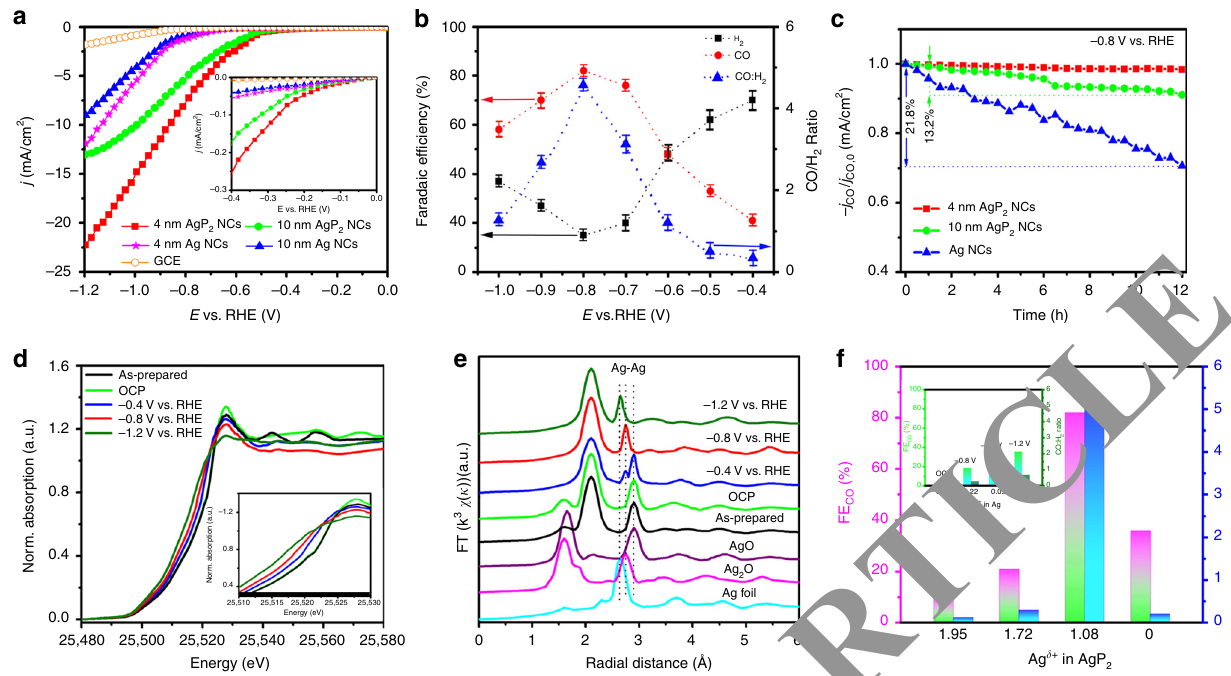
Fig. 2 Electrochemical measurements in CO 2 -saturated 0.5 M KHCO 3 solution. a Linear sweep voltammetric curves; b Faradaic ef fi ciency of CO and H 2 and CO/H 2 ratio; c stability of partial CO current density ( j CO ) measured at − 0.8 V vs. RHE for 12 h. d In situ silver K-edge XANES and e EXAFS spectra of 4 nm AgP 2 NCs after 30 min at the speci fi ed potential. Pristine AgP 2 NCs, AgO, Ag 2 O, and Ag foil are included as references. f Faradaic ef fi ciency of the CO and CO:H 2 ratio as a function of Ag δ + in AgP 2 and Ag. Fig. 12). For comparison, a much lower FE CO,max and narrower (EASA) and interfacial charge transfer rate (Supplementary Figs. 8a and 9). The onset potential ( E onset, CO ) for initial CO CO:H 2 range is observed for Ag NCs (Supplementary Tables 6 generation (de fi ned as the potential required for j CO = − 0.01 mA and 7). To check that the NC surface is exposed, the effects of removing surface capping ligands on the electrochemical surface cm − 2 ) on 4 nm AgP 2 NCs is − 0.22 V vs. RHE, which is only area and FE CO are shown in Supplementary Fig. 13a – c. The Tafel 110 mV lower than the thermodynamic potential of CO 2 -to-CO reaction. In comparison, the E onset, CO for Ag NCs is − 0.59 V vs. RHE ( η = 480 mV). The 4 nm AgP 2 NCs exhibit an overpotential 10 nm Ag NCs is 105, 117, 168, and 184 mV/dec, respectively (Supplementary Fig. 14). The smallest Tafel slope for 4 nm AgP 2 for the same partial density of CO ( j CO ) that is consistently on the order of 0.3 V lower than 10 nm Ag NCs (Supplementary Fig. 10). NCs indicates that phosphorus plays a critical role in stabilizing The source of the anodic shift of onset potential and decreased the CO 2 - intermediate and accelerating the fi rst electron transfer overpotential for CO 2 -to-CO will be discussed below in detail. rate-determining step 6 . Additionally, the durability of 4 nm AgP 2 The performance of 10 nm AgP 2 NCs is also provided as a same- NCs, 10 nm AgP 2 NCs, and 10 nm Ag NCs was tested at a high size comparison to 10 nm Ag NCs, and also exhibit uniformly constant potential of − 0.8 V vs. RHE (Fig. 2c). A stable j CO with superior performance compared to Ag NCs. Notably, the 4 nm negligible decay within 12 h is observed on 4 nm AgP 2 NCs, AgP 2 NCs exhibit a remarkable geometric j CO of − 0.27 and − 8.7 compared to 13.2% and 21.8% activity decay for 10 nm AgP 2 NCs mA cm − 2 at − 0.5 and − 1.0 V vs. RHE, respectively, which is the and Ag NCs, respectively. ICP-MS, TEM, and XPS con fi rm that the 4 nm AgP 2 NCs remain almost the same after 12 h CO 2 one of the highest values reported for Ag-based electrocatalysts for CO 2 reduction (Supplementary Table 4). A maximum FE CO reduction (Supplementary Figs. 15 – 17). of 82% and minimum FE H2 of 15% is simultaneously achieved at − 0.8 V vs. RHE (Fig. 2b), indicating CO 2 -to-CO reduction is more favorable than the competitive HER on 4 nm AgP 2 NCs. The CO:H 2 ratio in the syngas product varies from 1:3 to 5:1 in the potential range of − 0.4 to − 1.0 V vs. RHE. This is the widest range of syngas proportions for all Ag-based electrocatalysts (Supplementary Table 4), and even superior or comparable to ciency, such as Au – Cu (1:2 to 4:1) 41 , Pd/C (1:4 to 1:1) 42 , Co 3 O 4 - CDots-C 3 N 4 (1:4 to 14:1) 43 , MoSeS (1:3 to 1:1) 44 , and CdS x Se 1 − x (1:4 to 4:1) 45 . Notably, the 4 nm AgP 2 NCs achieve all the key syngas ratios with nearly 100% Faradaic ef fi ciency within an overpotential of 500 mV at stability for 12 h (Supplementary